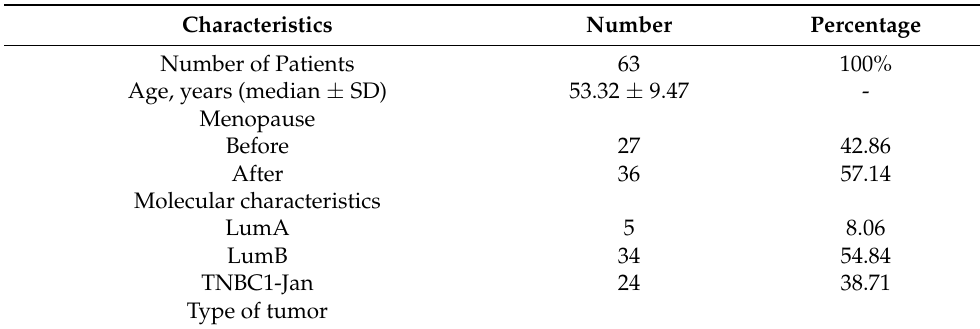
Table 1. Patients and tumors